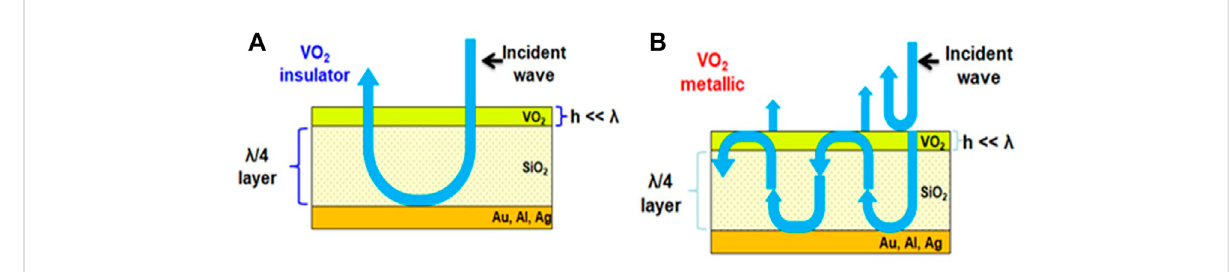
FIGURE 6 Simple schematic explaining the functionality of the VO 2 - (A) For the VO 2 in insulator state, the structure is an IR-re fl ector (Low emittance); (B) For the VO